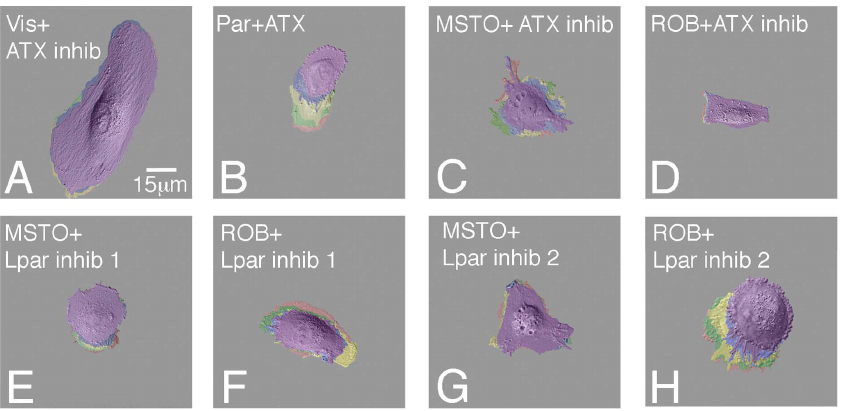
Figure 7. Autotaxin signaling regulates mesothelial and mesothelioma cell migration. Visceral mesothelial, parietal mesothelial, pleural mesothelioma (MSTO), and peritoneal mesothelioma (ROB) cells were plated on fibronectin, cultured with or without the addition of autotaxin, the autotaxin inhibitor S32826, Lpar1 inhibitor 1 (2440), or Lpar1 inhibitor 2 (8437), and subjected to time-lapse imaging in order to visualize their ability to migrate. Panels A-H are compilations of static images taken at 20 minute intervals. False coloration indicates a cell’s location at each interval: red 0 min; green 20 min; yellow 40 min; blue 60 min; purple 80 min.